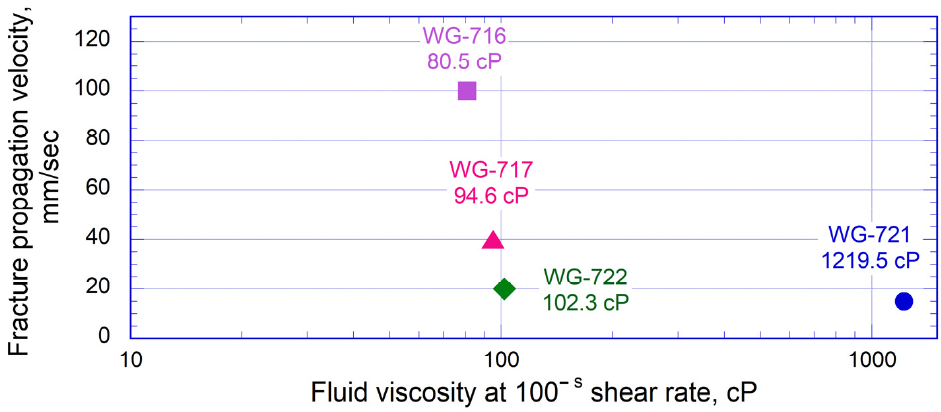
Figure 20. The relationship between injected fluid viscosity and fracture propagation velocity.